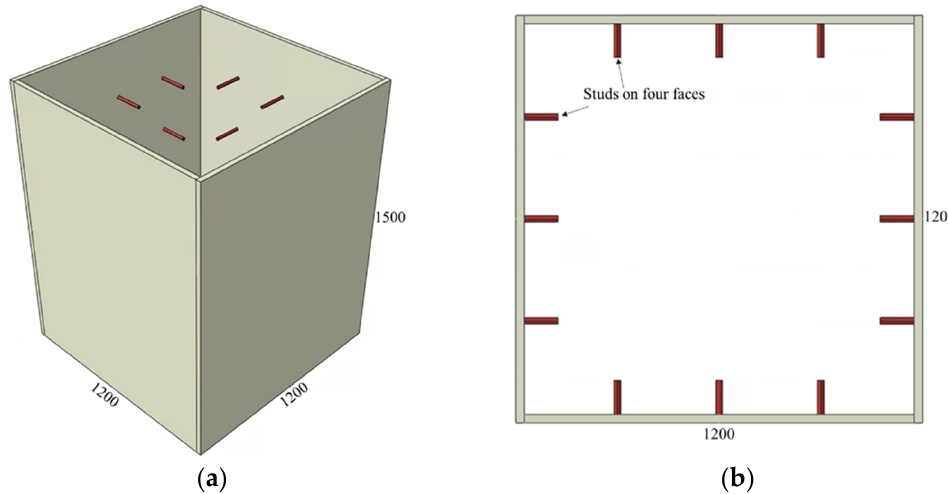
Figure 2. CFST column with shear studs on all faces: ( a ) 3D view and ( b ) top view.